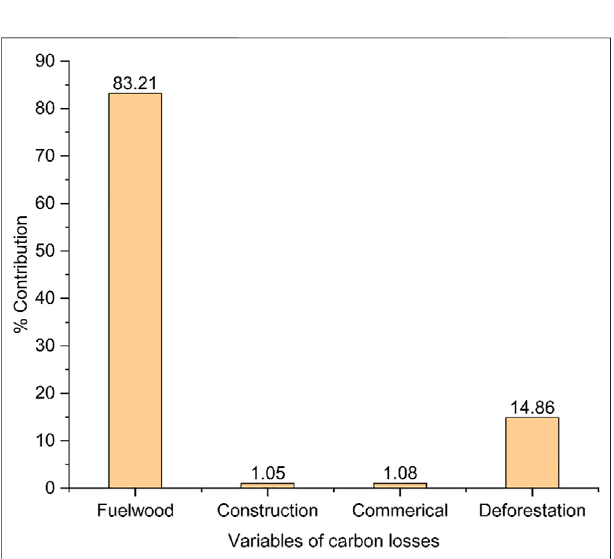
FIGURE 6 | Contribution of deforestation and wood harvest to carbon